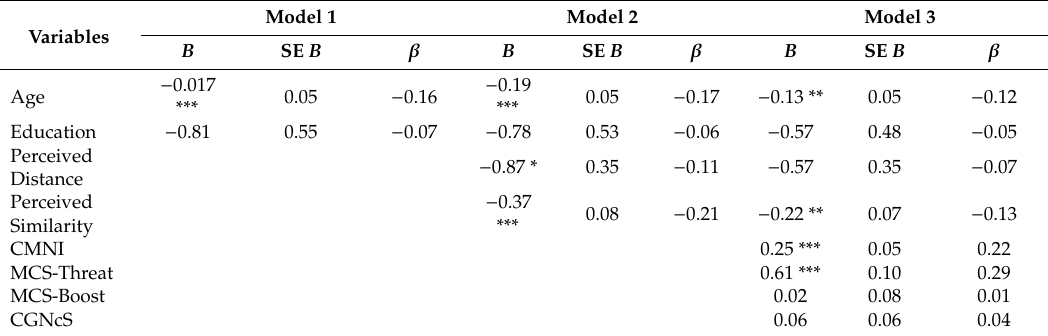
Table 4. Regression coe ffi cients of the predictors on internalized